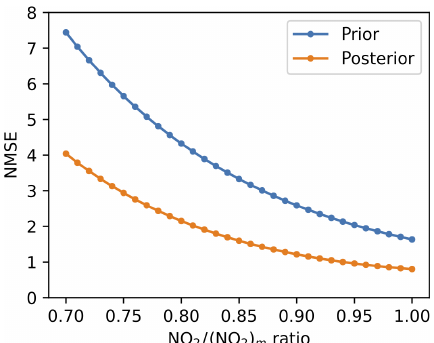
Figure 6. Normalized mean squared error (NMSE) for NL-DC-PRI (blue line) and NL-DC-POS (orange line) when evaluating with in situ surface NO 2 derived from various NO 2 /( NO 2 ) m ratios (in- creasing from 0.7 to 1.0 with a step of 0.01), where ( NO 2 ) m is measured NO z